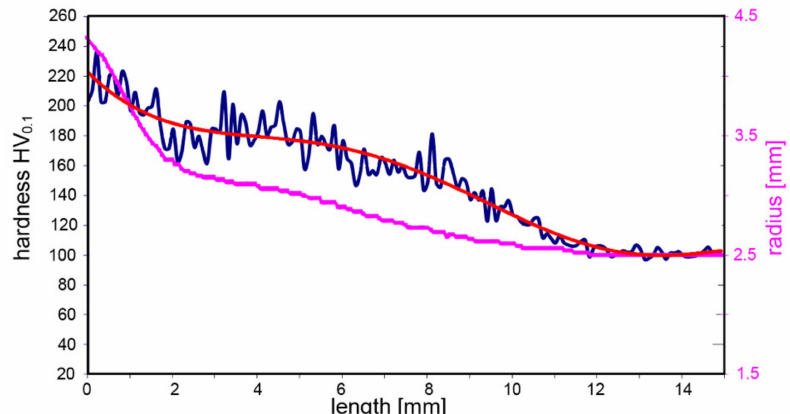
Figure 7. Geometry of tested specimen in correlation with HV0.1 hardness values.